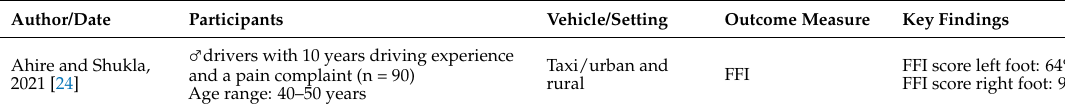
Table 3. Data extraction